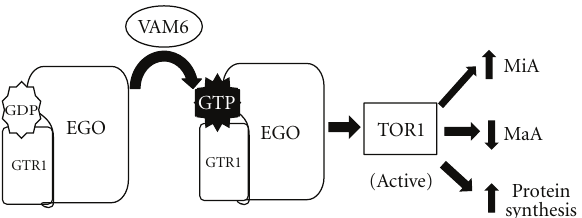
Figure 4: Activation of TOR1 in microautophagy. Vam6 activates Gtr1 of the EGO complex leading to the activation of TOR1. Through the activation of TOR1, microautophagy levels increase and the cell increases protein synthesis as it returns to a growing state. MaA, typically activated in nutrient deprived conditions, is inhibited.